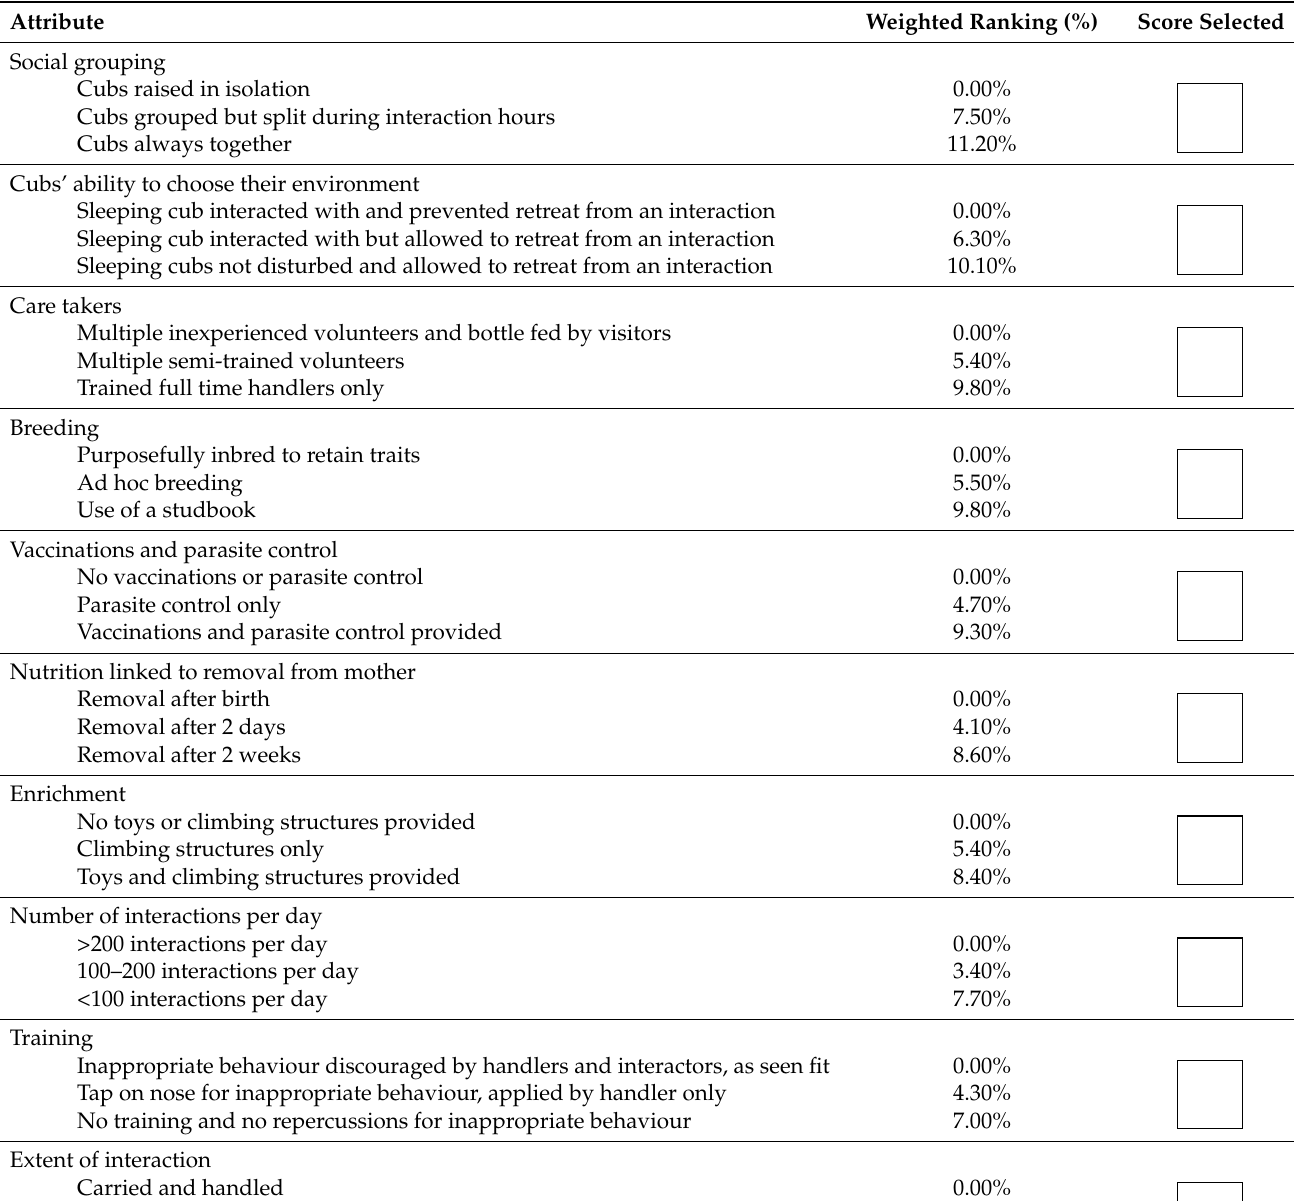
Table 4. A value model (%) for rating the welfare of lion cubs used in tourism (wildlife interaction facilities).